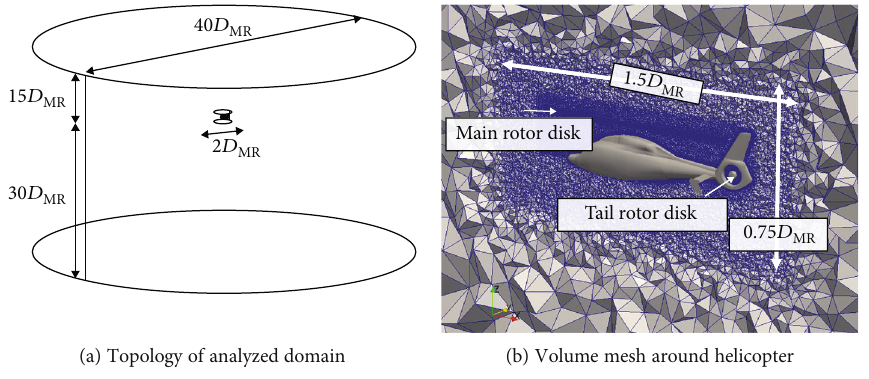
Figure 5: Computational domain.